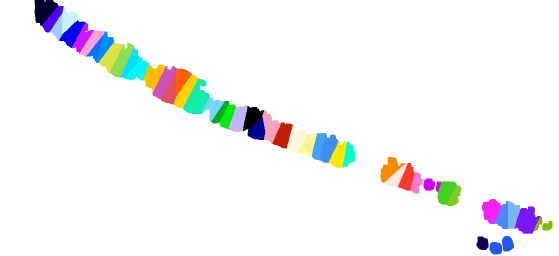
Figure 11: Individualization trees in 2D